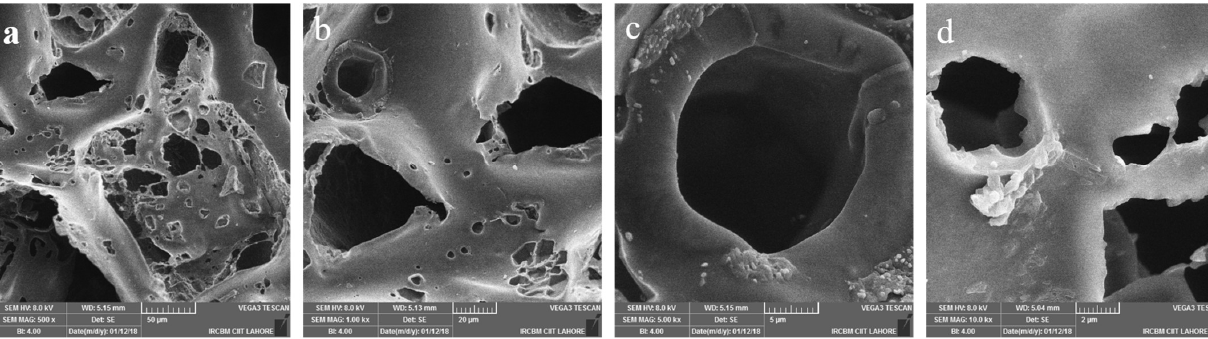
micro and PU/HA nano scaffolds. Figure 1. SEM images of PU, PU/HA